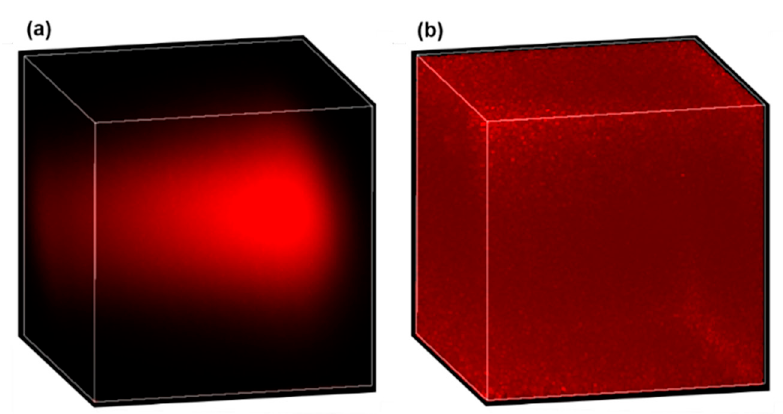
Figure 7. Effective correction for nonuniform signal efficiency by normalization. A 3D image of a uniform 10 µg/mL doxorubicin solution before ( a ) and after ( b ) normalization. uniform 10 µ g/mL doxorubicin solution before ( a ) and after ( b )